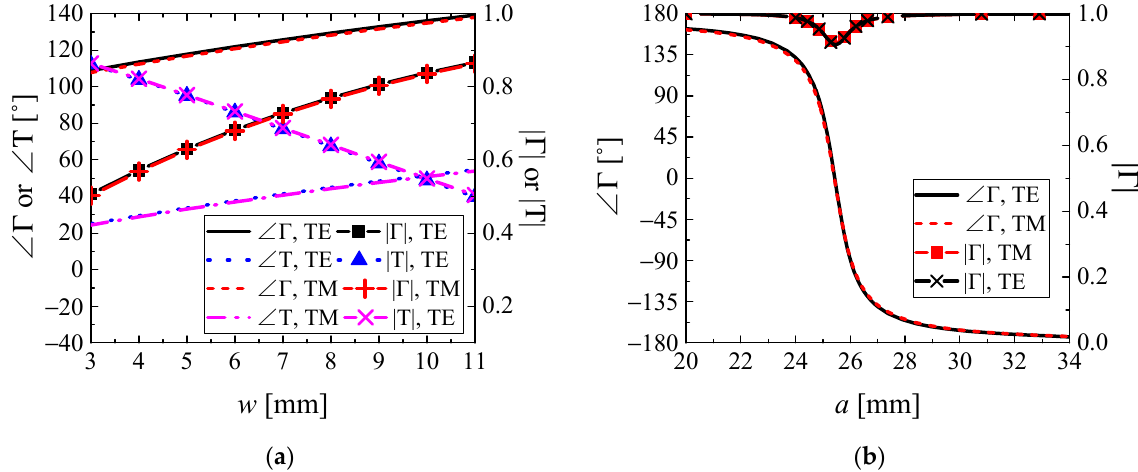
Figure 8. Reflection and transmission coefficients of ( a ) the PRS and ( b ) the AMC cell. All characteristics are obtained at the design frequency.